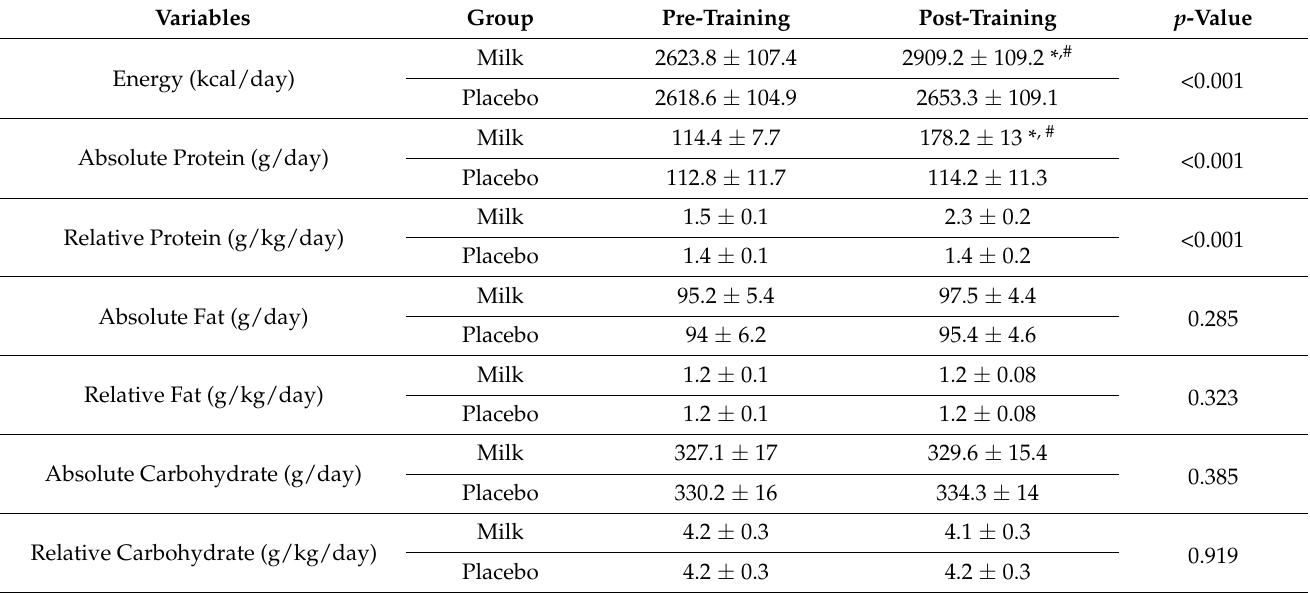
Table 3. Energy and macronutrients (mean ±